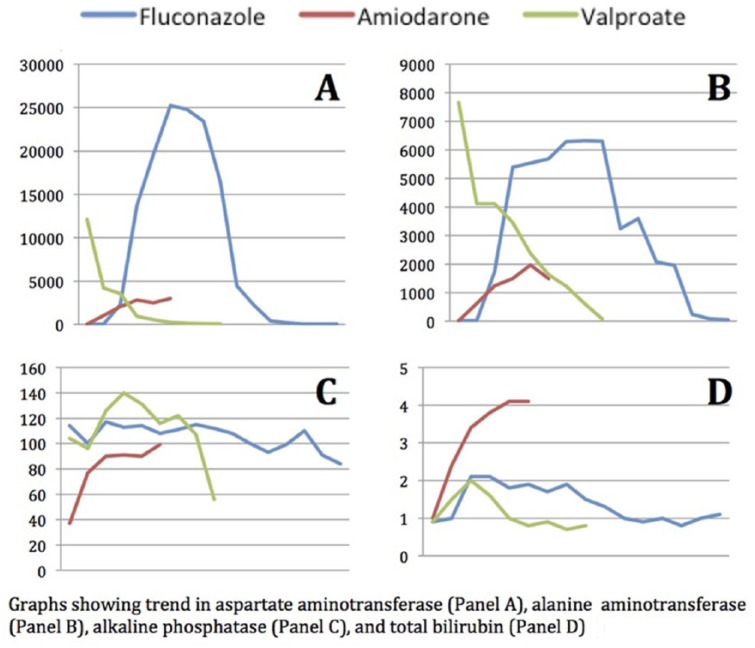
Trends in liver function tests.